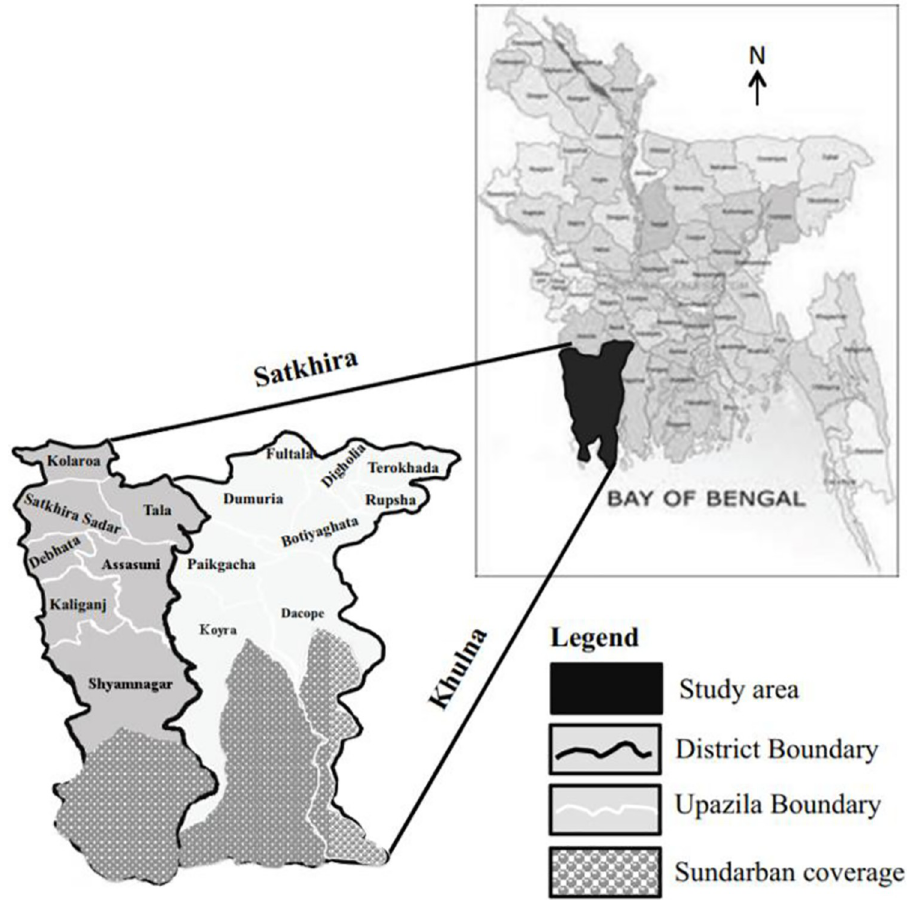
Fig 2. Study region in Bangladesh. Source: